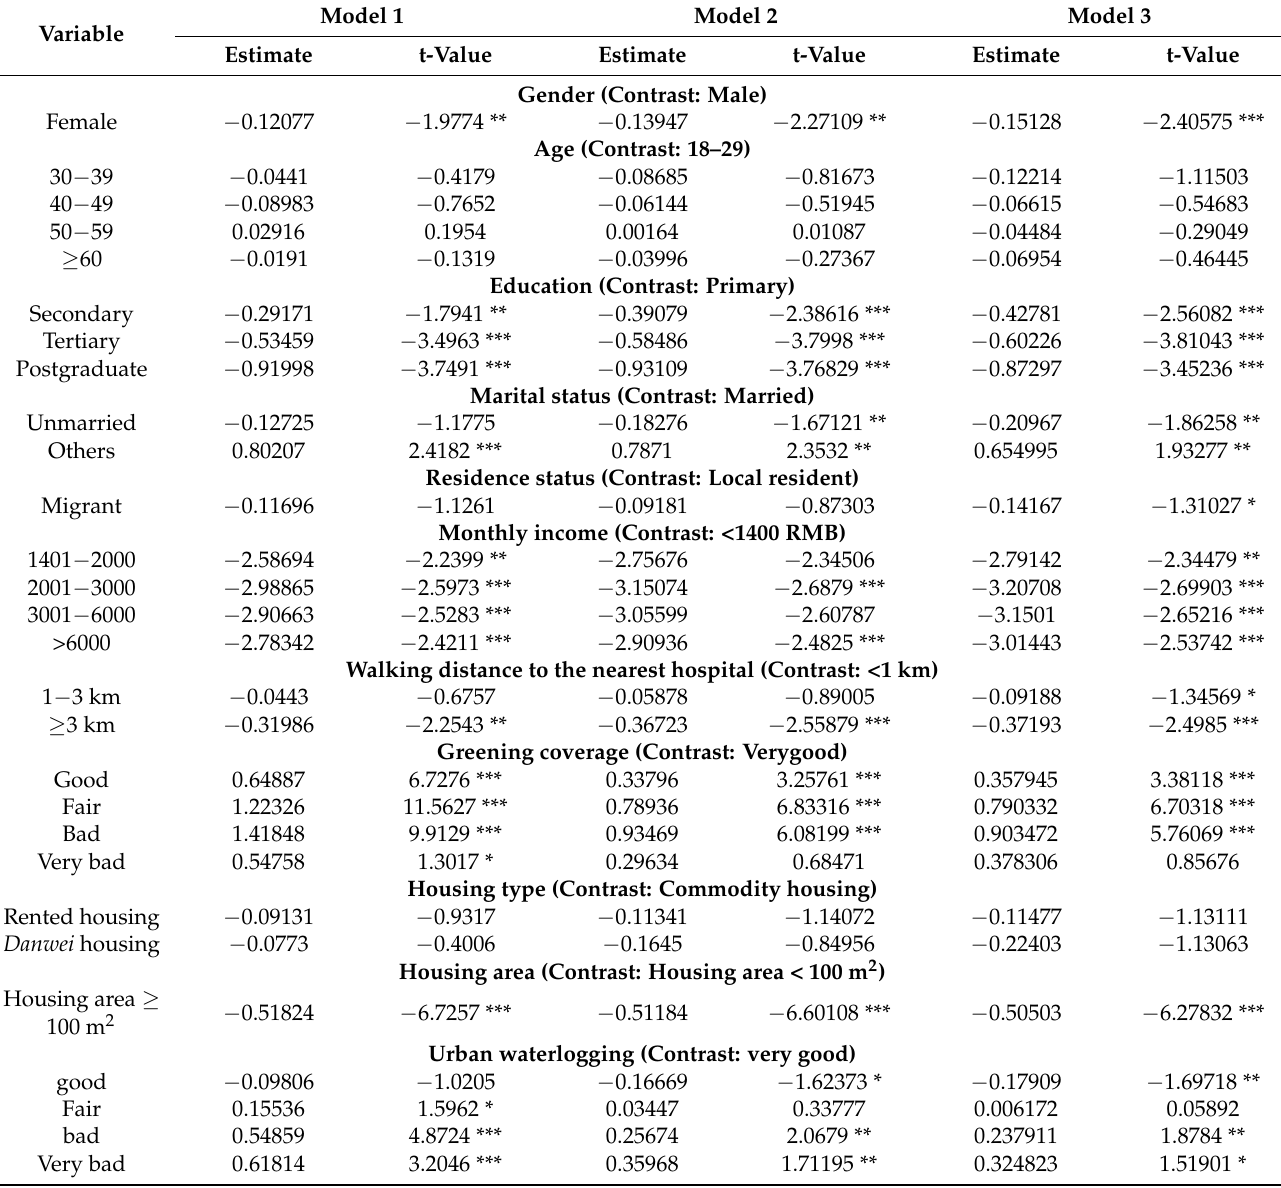
Table 2. Multivariate linear regression results of residents’ subjective health